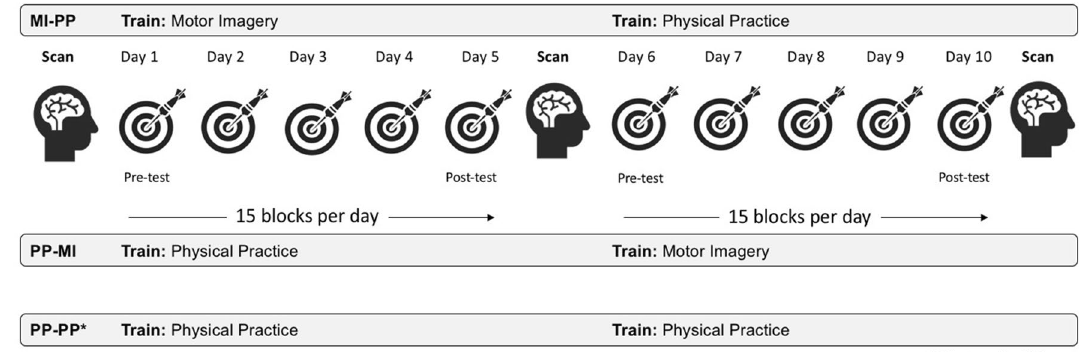
Figure 1. Timeline of the experimental design. Participants engaged in ten training sessions of a dart throwing task, via motor imagery prior to physical practice (MIP-PP), motor imagery following physical practice (PP-MIP), or physical practice only (PP-PP), based on group assignment. Participants completed four physical testing sessions in a pre/post design for each half of the study. Participants in the MIP-PP and PP-MIP groups also underwent three fMRI sessions (pre/mid/post-training) to capture changes in motor imagery-related brain activation of the dart throwing